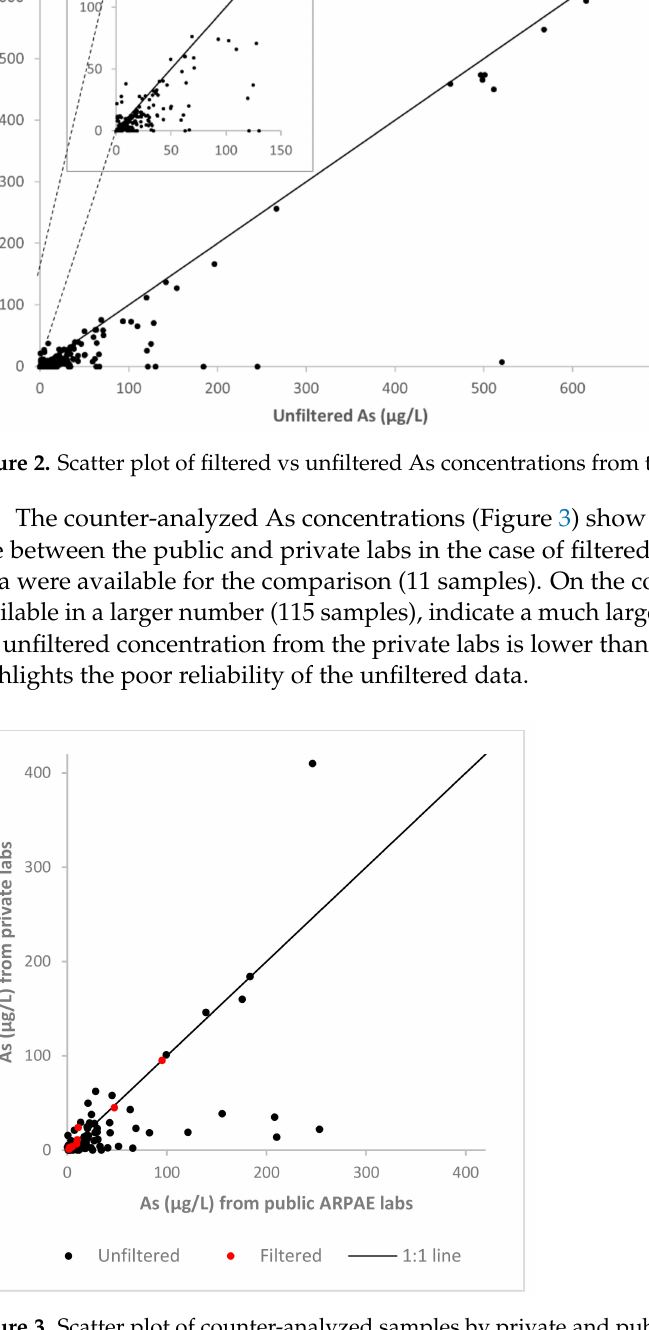
Figure 3. Scatter plot of counter-analyzed samples by private and public